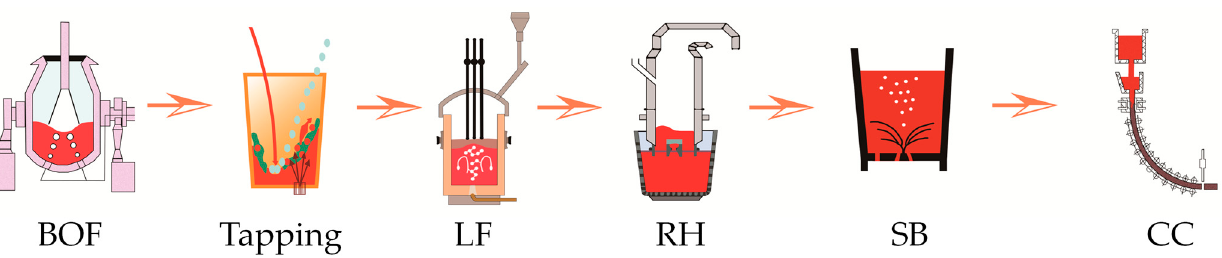
Figure 1. Production process of high-chromium bearing steel.